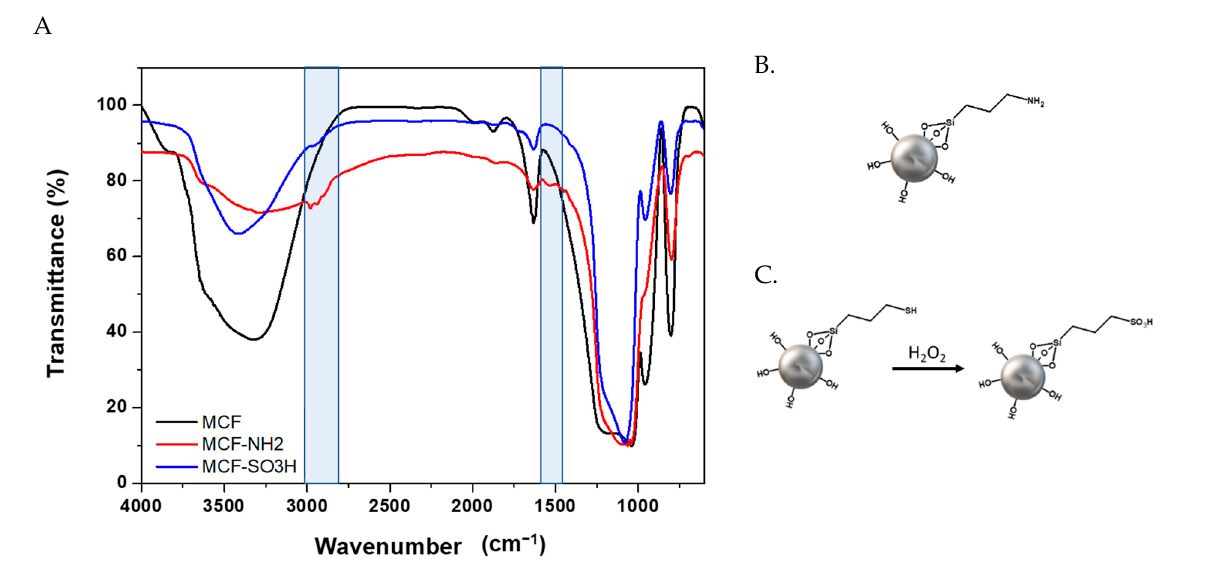
Figure 6. ( A ) Infrared spectrum of MCF silica before and after modification with APTES; ( B ) scheme of silica modified with APTES (MCF-NH 2 ); and ( C ) with MPTMS (MCF-SO 3 H).